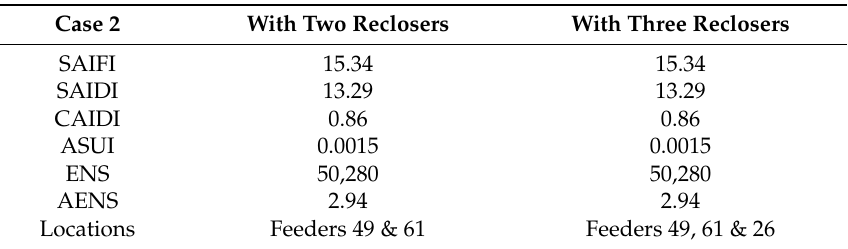
Table 4. System indices with changing the number of